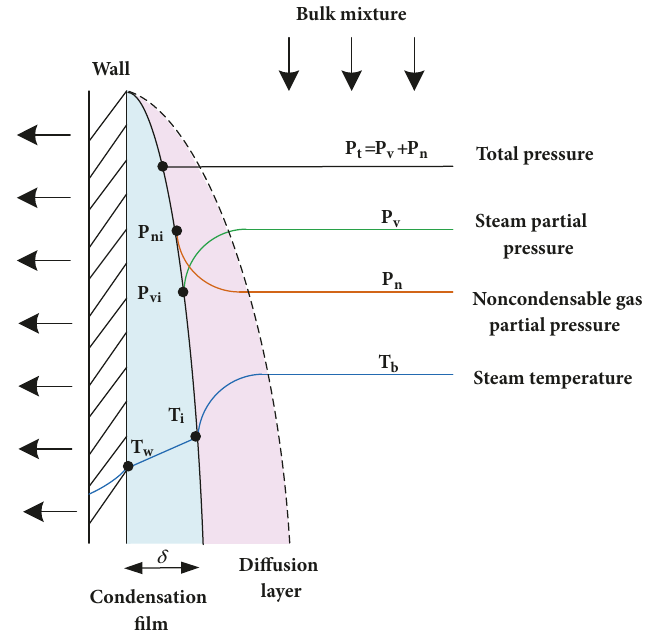
Figure 1: Heat transfer processes of condensation with the presence of noncondensable gases.